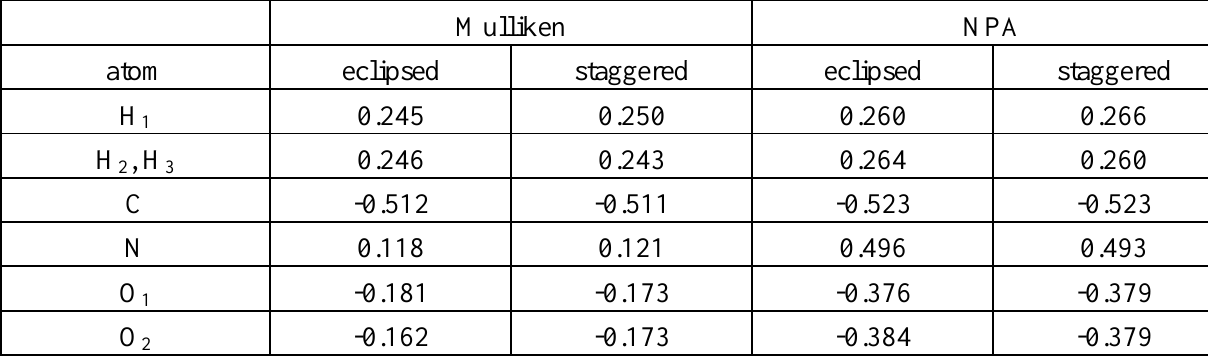
Table 2. Mulliken and NPA atomic charges in the nitromethane molecule.